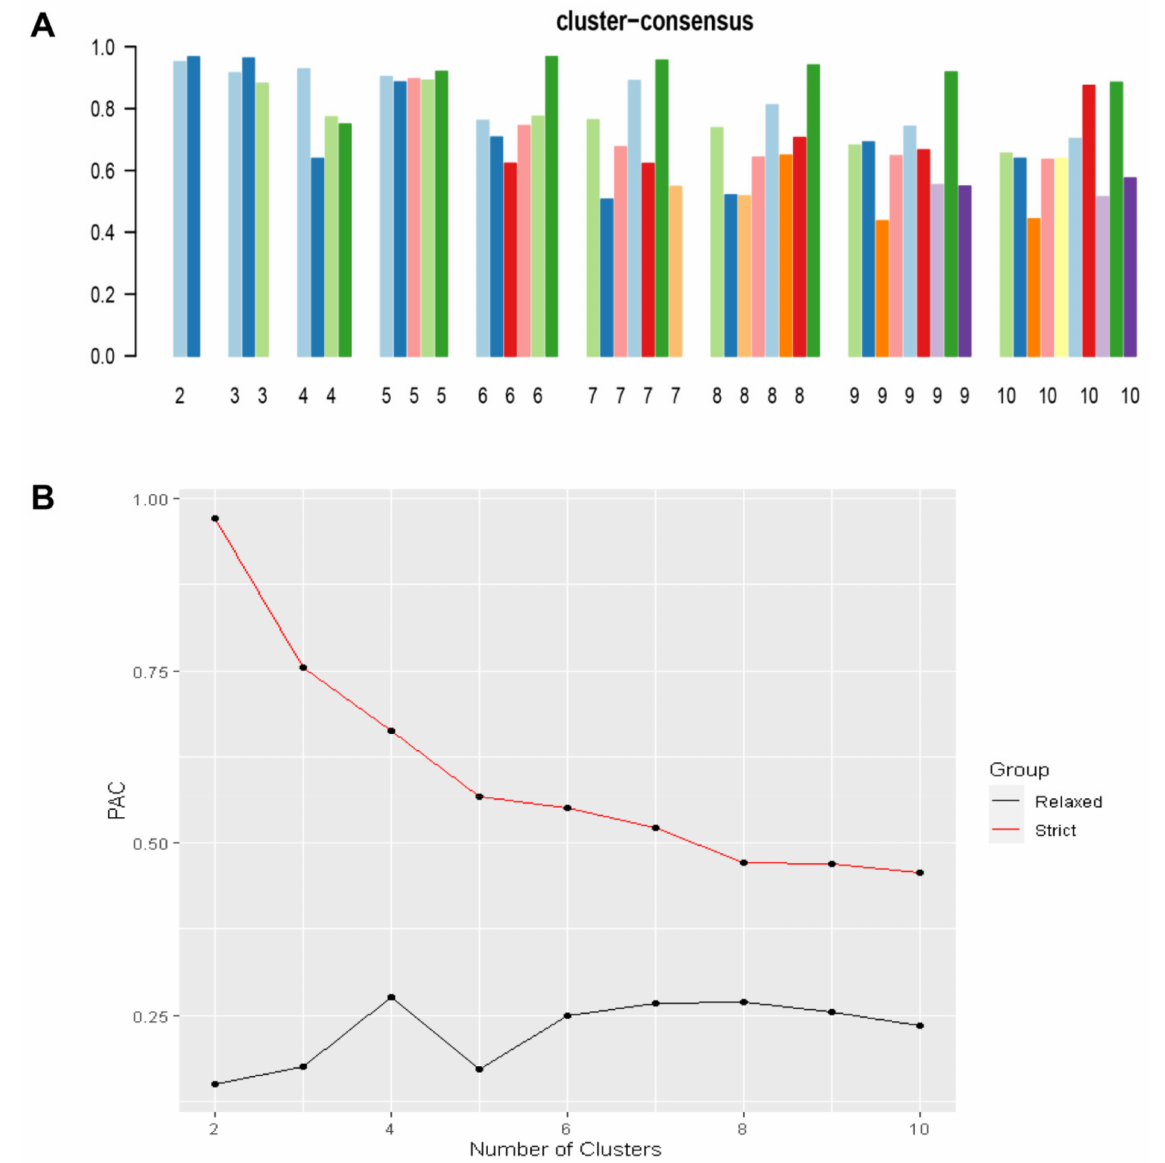
Figure 2. ( A ) The bar plot represents the mean consensus score for different numbers of clusters (k ranges from two to ten). ( B ) The PAC values assess ambiguously clustered